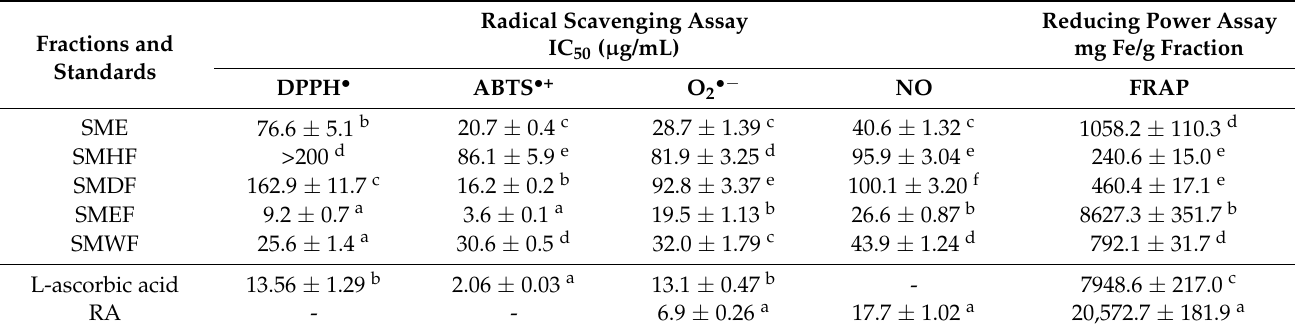
Table 1. Antioxidant activity as IC 50 and ferric reducing/antioxidant power (FRAP) of perilla seed meal (PSM) fractions determined by different assays using ascorbic acid and rosmarinic acid (RA) as the positive control. Fractions